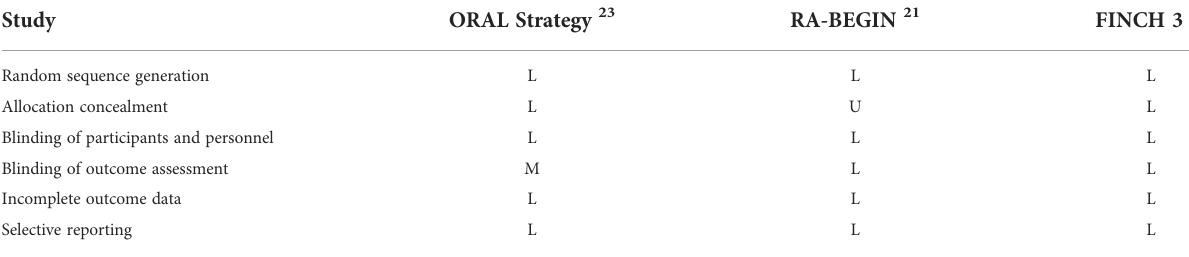
TABLE 2 Quality assessment results of included randomized controlled